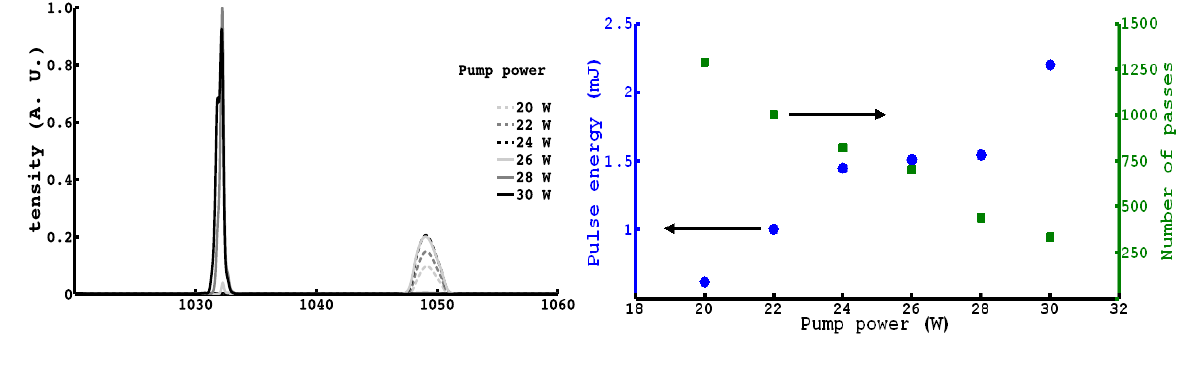
Figure 6. Simulation of regenerative amplification based in Yb:YAG in injection mode. Left : Output intensity vs . wavelength for a range of pump power; Right : output energy and required number of passes vs . pump